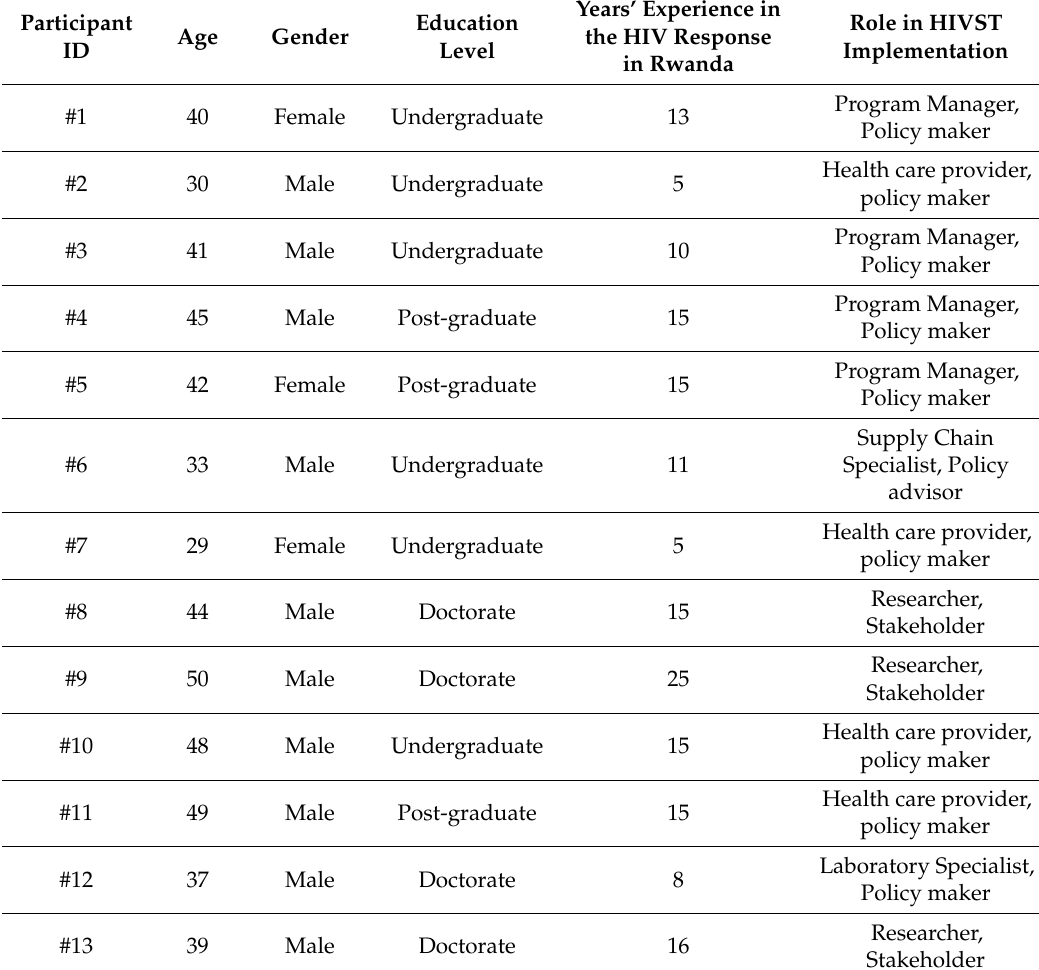
Table 1. The presentation of key stakeholders by age, gender, highest qualification, number of years’ experience in the HIV response and role in HIVST implementation in